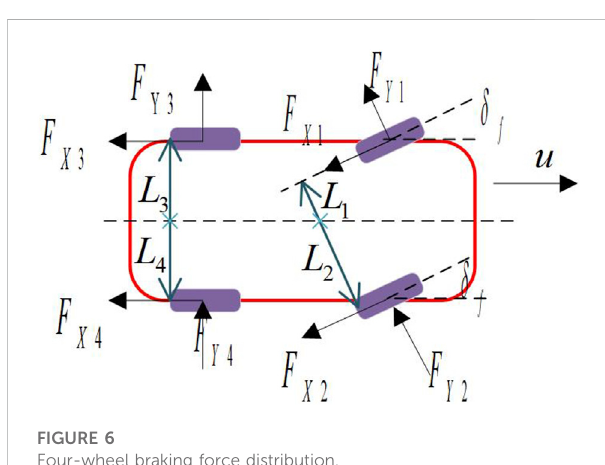
FIGURE 6 Four-wheel braking force